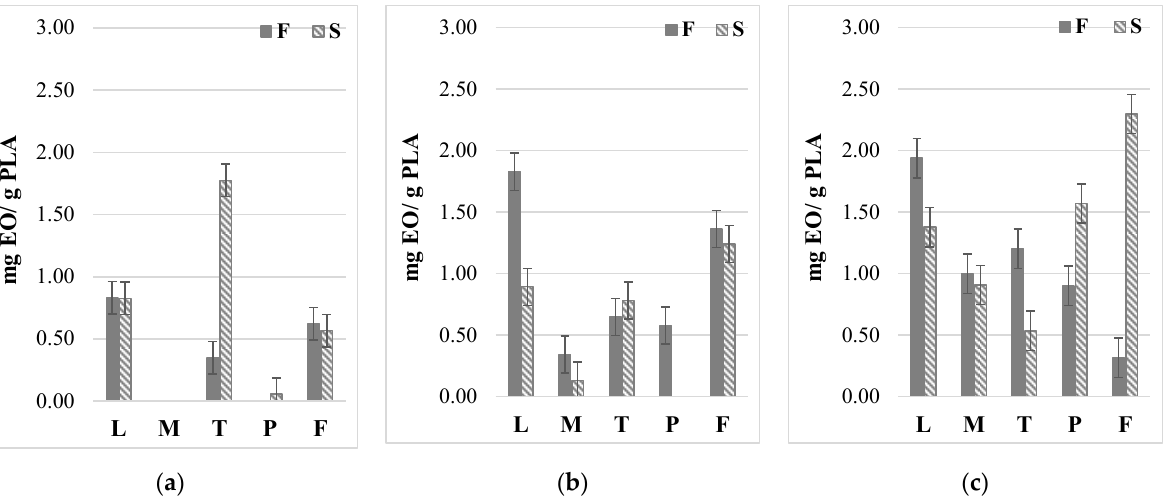
Figure 4. The specific amount of essential oil in ethanol solutions at different concentrations: ( a ) 1 wt.% solution; ( b ) 1.5 wt.% solutions; ( c ) 2 wt.% solutions.